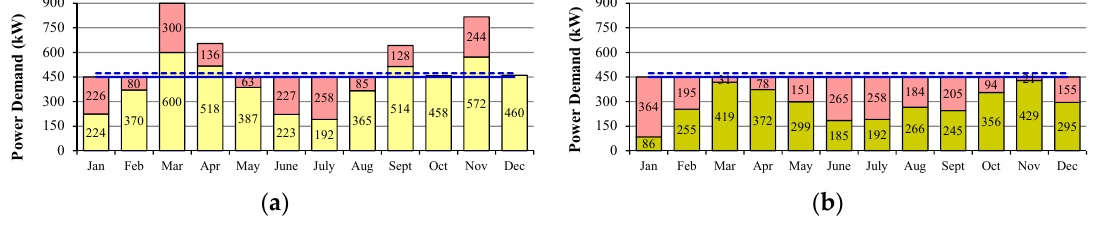
Figure 4. Reference scenario demand values for ( a ) off-peak ( b ) on-peak.